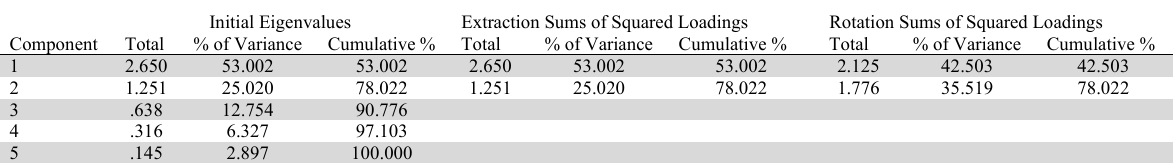
The result of Test of Eigenvalues Component